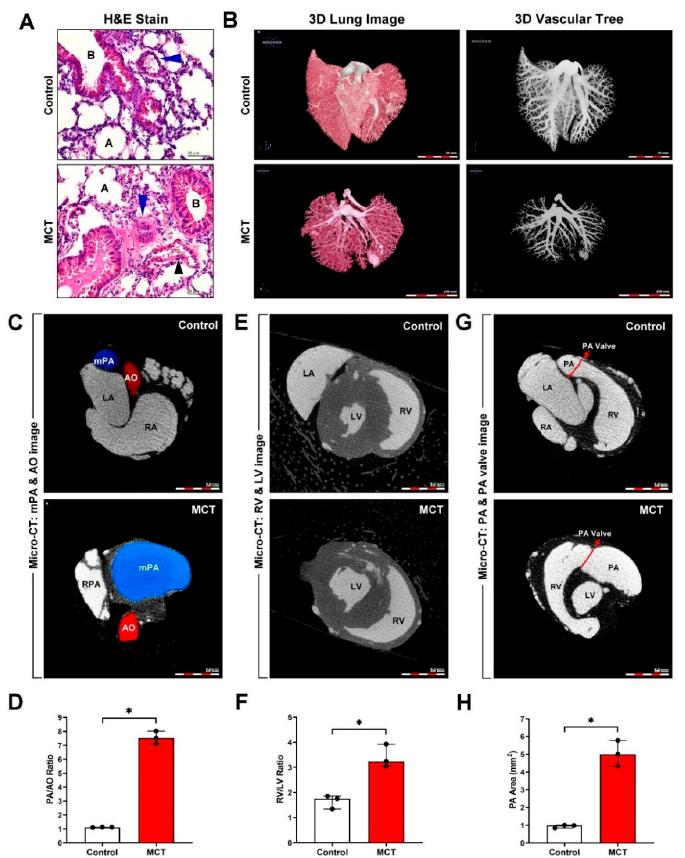
Figure 1. Monocrotaline (MCT)-induced pulmonary artery hypertension (PAH) in mice. C57BL/6 mice were treated with or without MCT (right side, 60 mg/kg; IP, once) for 30 days. ( A ) Hematoxylin and eosin (H&E) staining revealed a thicker pulmonary artery wall (blue arrows) following MCT- induced PAH. A, alveolar; B, bronchial; black arrows, vein. ( B ) The 3D lung image and vascular tree image were obtained by contrast-enhanced micro-computed tomography (MicroCT). ( C , D ) The mean pulmonary artery (mPA) and aortic artery (AO) image and PA/AO ratio; ( E , F ) left ventricle (LV) and right ventricle (RV) image and RV/LV ratio; ( G , H ) PA area was measured using MicroCT and Image J software. Data are representative of three independent experiments ( n = 3), and values are expressed as median and interquartile range. Mann–Whitney U-test was used to compare two independent groups (* p < 0.05).